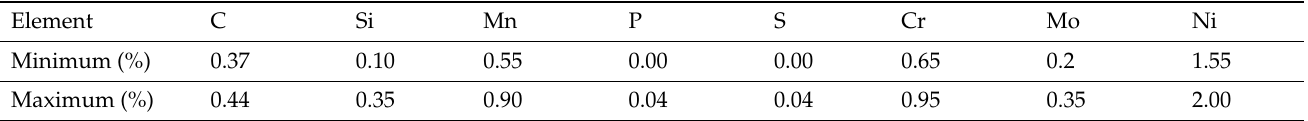
Table 1. AISI 4340 composition (wt.%) [17].